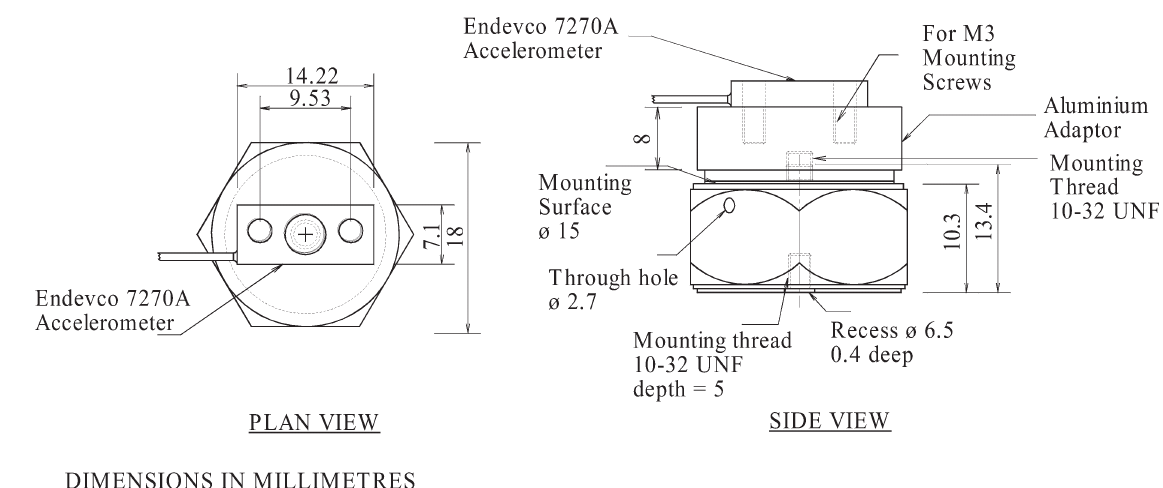
Fig. 3. Detail of the 7270A-B&K